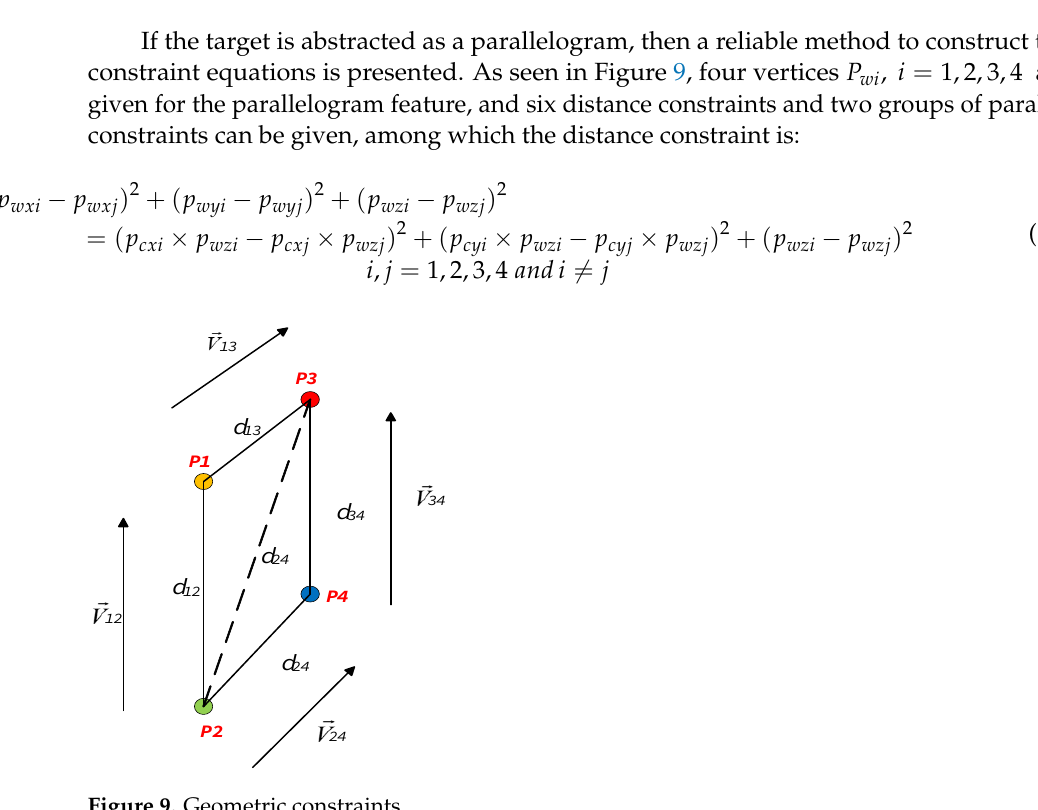
Figure 9. Geometric constraints.